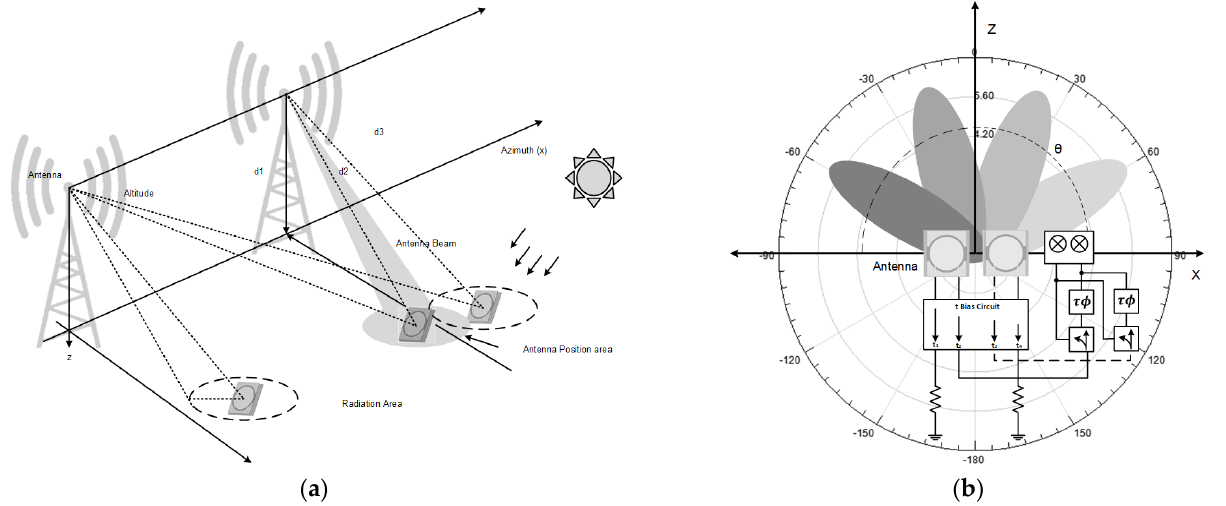
Figure 18. ( a ). Schematic analysis of antenna configuration on the wireless sensor ( b ). CP antenna adaptive analysis of the radiation pattern.